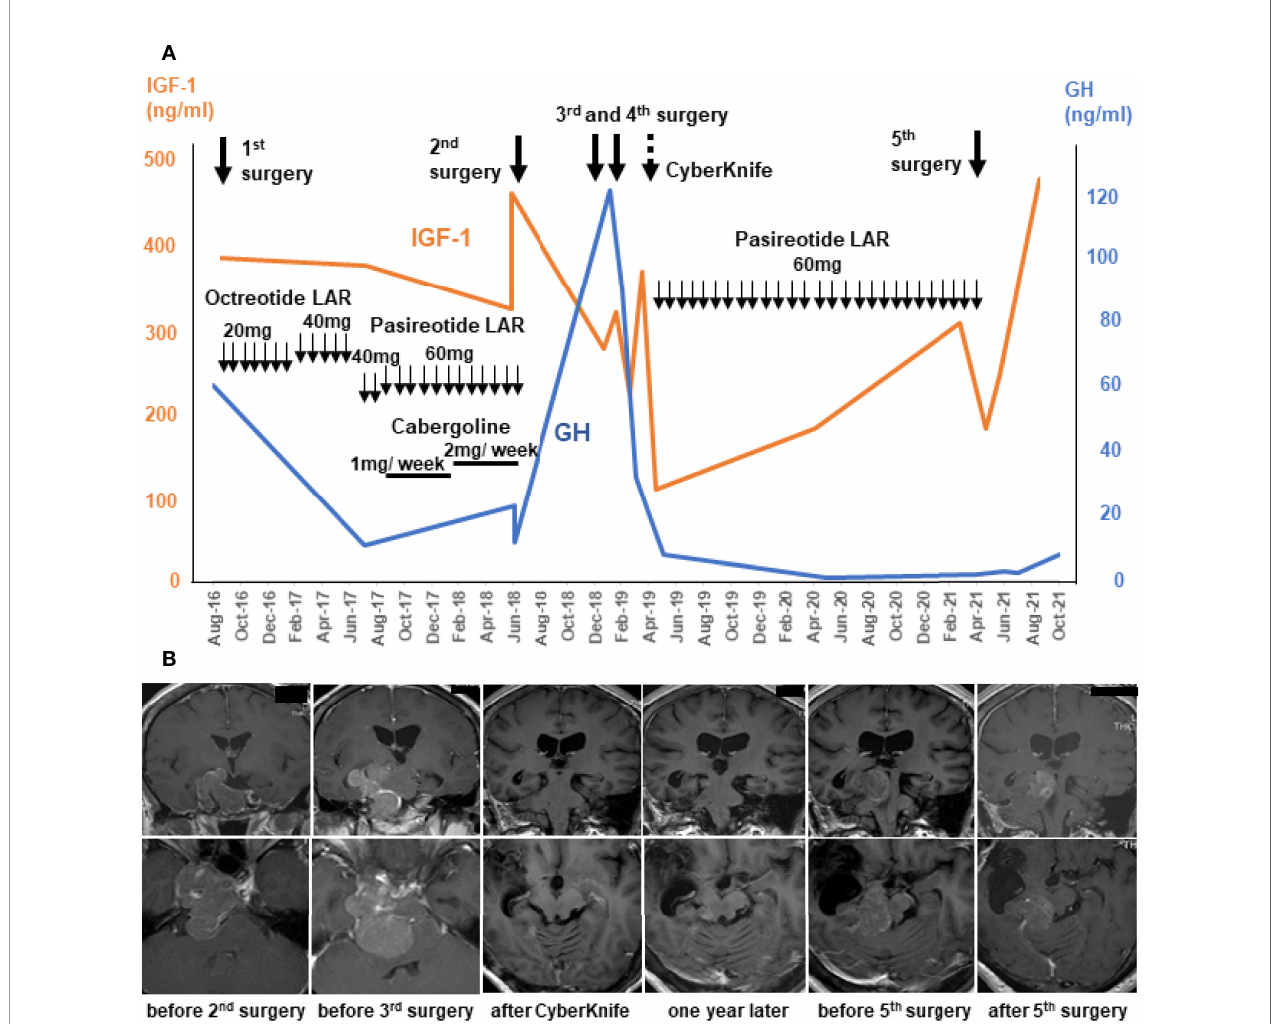
FIGURE 1 | Clinical course and management of the patient using multimodal treatment strategy until temozolomide and capecitabine (CAPTEM). Serum levels of growth hormone (GH; blue lines) and insulin-like growth factor-1 (IGF-1; orange lines) before CAPTEM (A) . Gadolinium-enhanced MR T1 images show that the tumor initially extending laterally to the right and posteriorly, and fi nally localized right-dorsal part of the brainstem. The upper row is coronal images and the lower row is axial images (B)